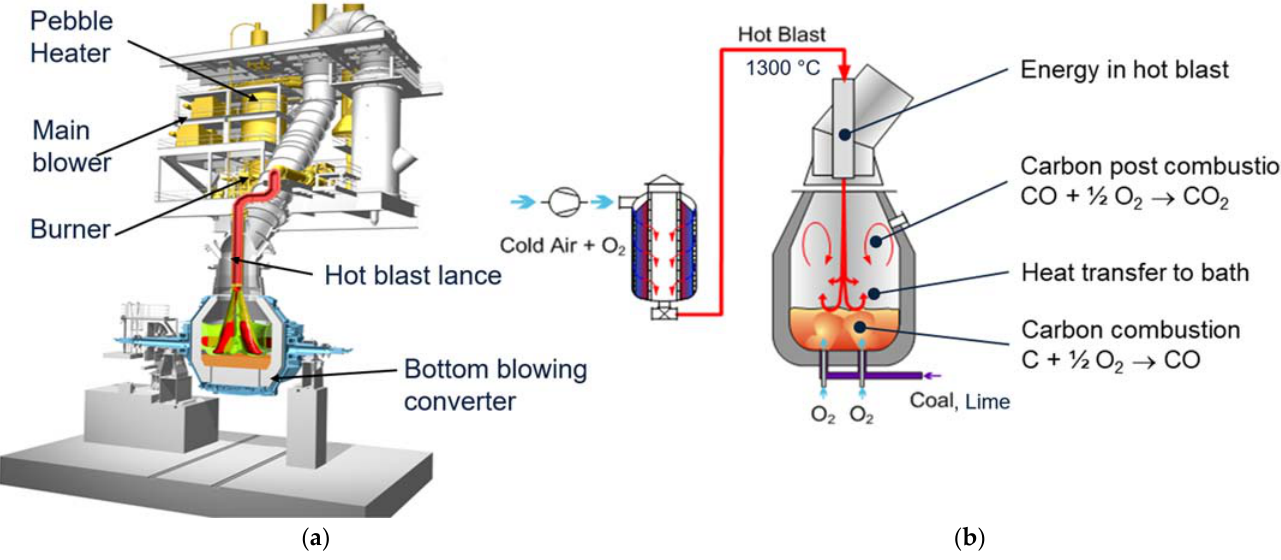
Figure 11. ( a ) Main components of the JET converter and hot blast system. ( b ) Process and the principle of JET converter: Hot blast system for highest post-combustion and bottom blowing converter with lime and coal injection.